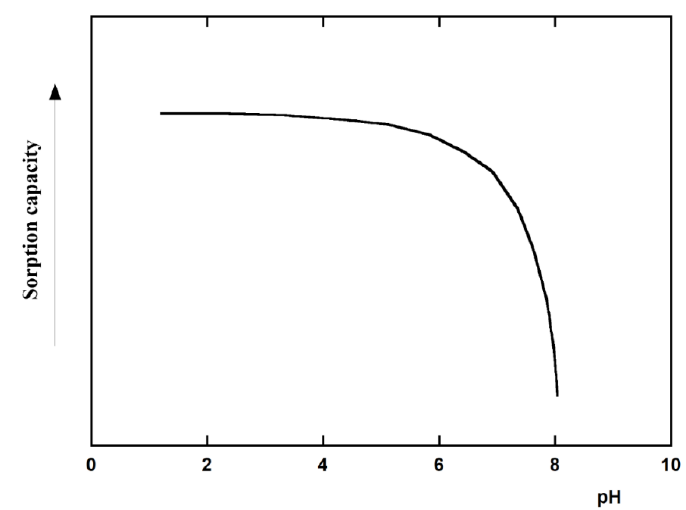
Figure 2. Typical decreasing trend of Cr(VI) sorption capacity vs. pH.